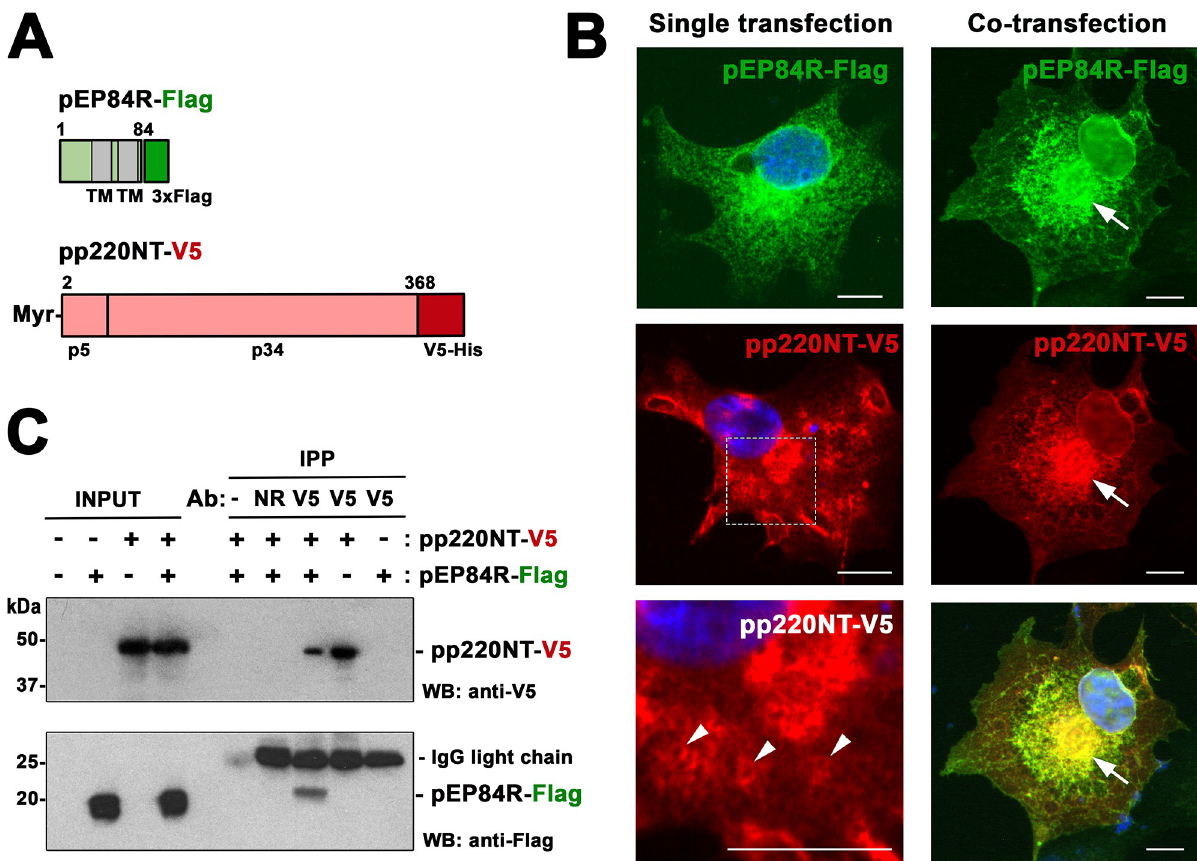
Fig 7. Transmembrane protein pEP84R interacts with the N-terminal region of polyprotein pp220. (A) Schematic representation of pEP84R-Flag and pp220NT-V5 constructs. The putative transmembrane segments (TM) of pEP84R, the N-myristoyl moiety of pp220NT, the His-V5 (pp220NT) and Flag (pEP84R) tags, and the regions corresponding to p5 and p34 products derived from pp220 are indicated. (B) Immunofluorescence detection of pEP84R-Flag and pp220NT-V5 in transfected cells. Cos cells transfected with pEP84R-Flag and pp220NT-V5 constructs individually or in combination, were immunolabeled with anti-pp220 (red) and anti-Flag (green) antibodies. Note vesicular-like pattern of pp220NT-V5 (middle left) indicated by arrowheads in a detail (bottom left) and colocalization (arrows in right panels) of pEP84R-Flag and pp220NT-V5 in co-transfected cells at the nuclear envelope and perinuclear areas. Bars, 10 μ m. (C) Co-immunoprecipitation of pEP84R-Flag with pp220-NT-V5. Clarified lysates of Cos cells co-transfected with pEP84R-Flag and pp220NT-V5 constructs were incubated with no antibody (-), a non-relevant (NR) antibody against MCP p72 (mAb 1BC11) or an anti-V5 mAb followed by protein G magnetic beads. As negative controls, lysates of cells expressing pEP84R-Flag or pp220NT-V5 individually were immunoprecipitated with anti-V5 mAb. Total extracts (INPUT) and immunoprecipitated proteins (IPP) were analyzed by western blot with anti-V5 and anti-Flag mAbs. The molecular masses (in kDa) as well as the pEP84R-Flag and pp220NT-V5 bands are indicated.